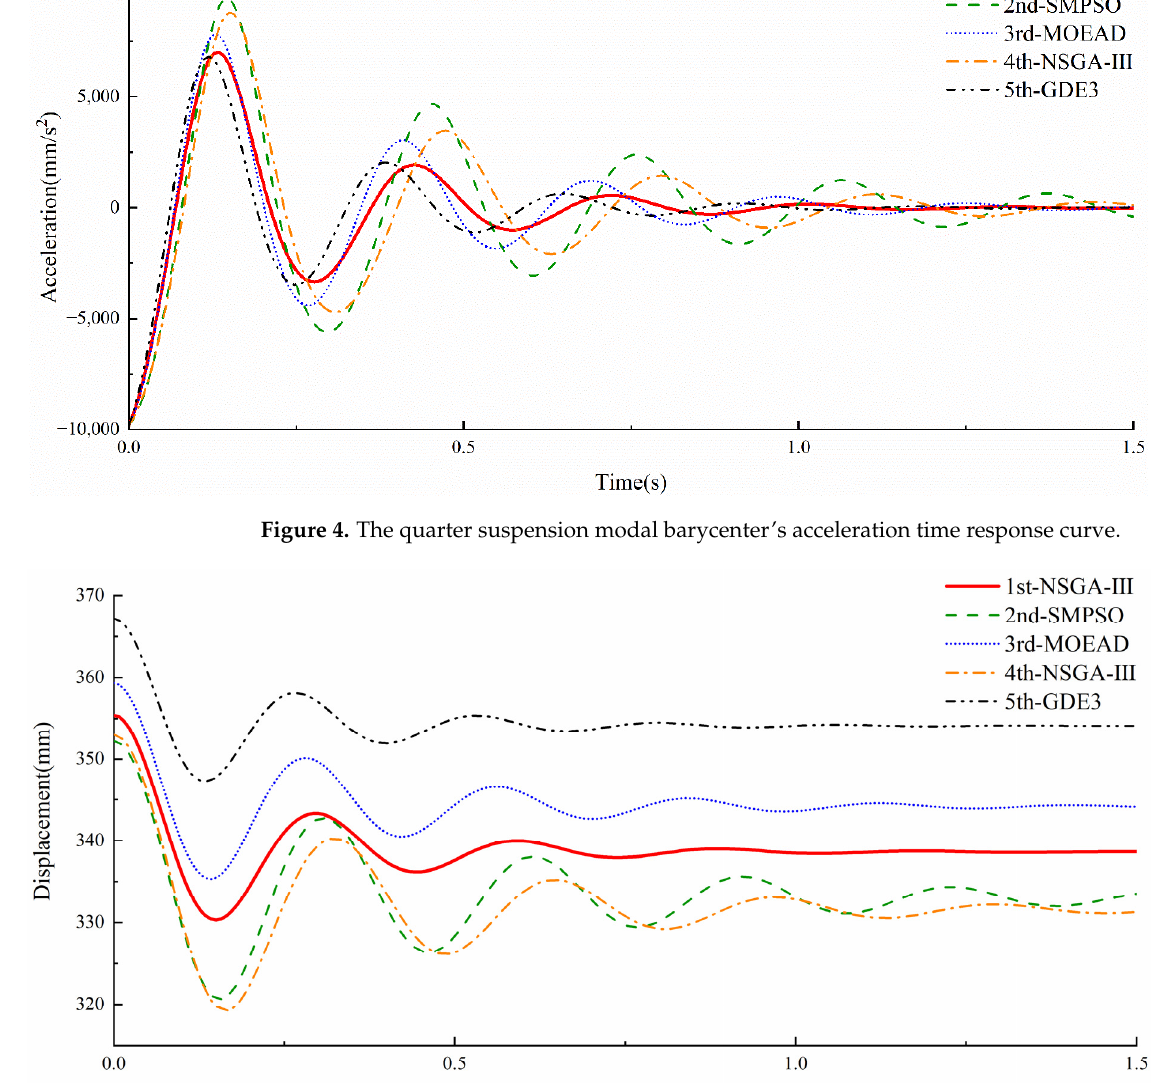
Figure 5. The quarter suspension modal barycenter’s height displacement time response curve.